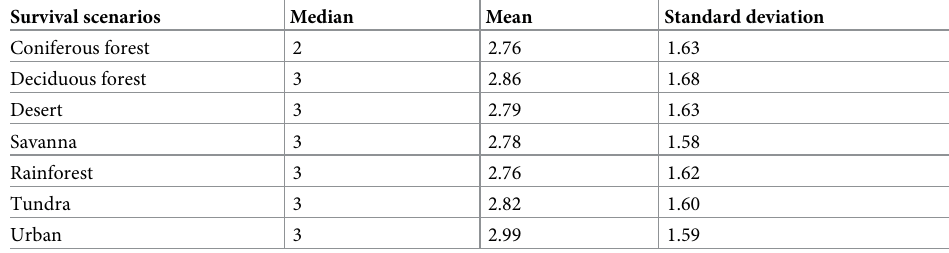
Table 2. Median differences (Kruskal–Wallis) and the descriptive analysis of the words rating in the survivor scenarios. Survival